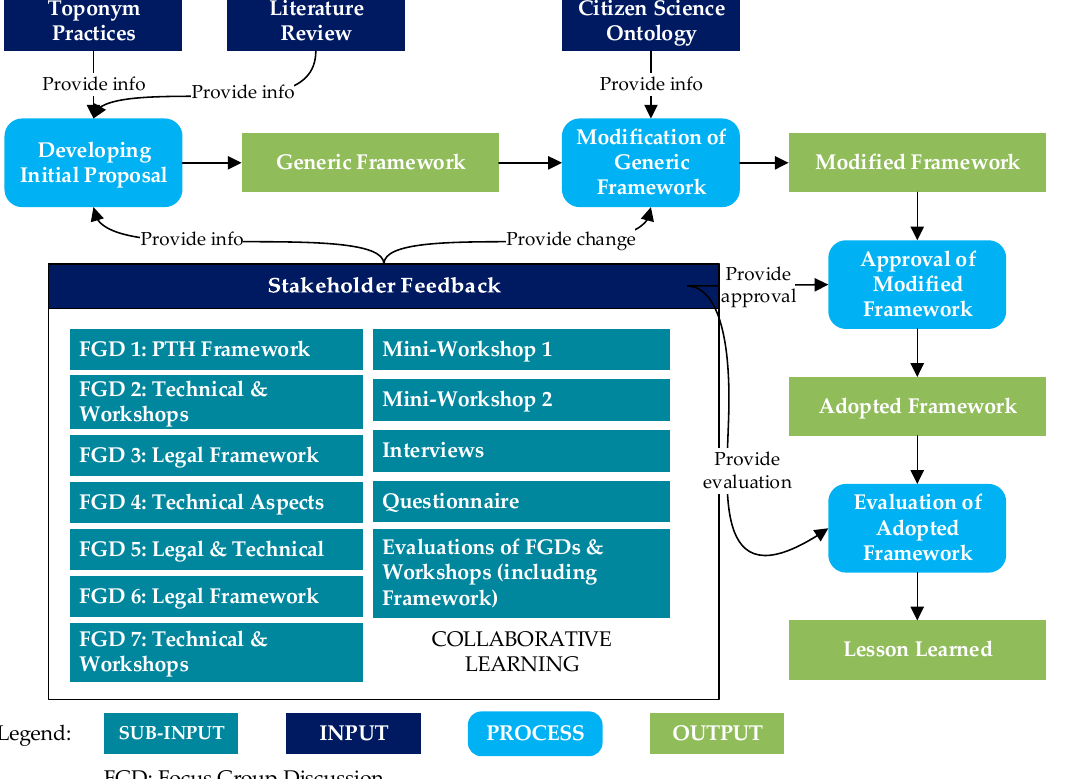
Figure 1. Research workflow.